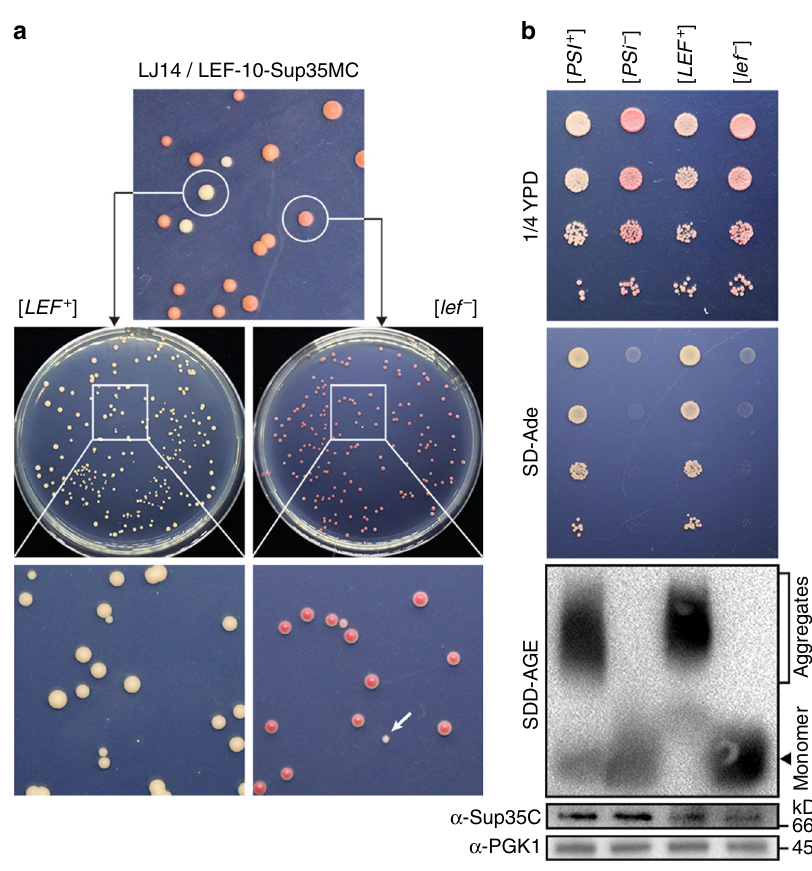
Fig. 2 LEF-10 functionally replaces the prion domain of the yeast Sup35 protein. a Yeast ade1-14 cells expressing LEF-10-Sup35MC were spread on complete (1/4 YPD) medium. [ LEF + ] strains formed white colonies which were distinguishable from [ lef − ] strains by the red pigment accumulated through the adenine biosynthetic pathway (top). Both phenotypes could be sustained during cell propagation (middle). [ lef − ] strains spontaneously generated [ LEF + ] colonies at a very low frequency (bottom, a colony with the [ LEF + ] phenotype is indicated by an arrow) and these [ LEF + ] colonies displayed Ade + (suppression of ade1-14 ) phenotype when tested directly on SD-Ade medium. b Comparable characteristics of LEF-10-Sup35MC and full-length Sup35 in yeast. Serial dilutions of [ LEF + ] and [ lef − ] strains were spotted on the 1/4 YPD plate (the top panel), or medium lacking adenine (SD-Ade) on which only prion-containing i.e., [ PRION + ] strains suppressing the stop codon in the yeast ade1-14 allele could grow (the second panel). SDS-resistant aggregates in cell lysates of yeast strains expressing LEF-10- Sup35MC were examined by SDD-AGE (the third panel). The expression levels of full-length Sup35 and LEF-10-Sup35MC were examined by Western blot, probing with a Sup35C-speci fi c antibody (the fourth panel). Endogenous phosphoglycerate kinase 1 (PGK1) was detected with a PGK1-speci fi c antibody and served as a loading control (the bottom panel). [ PSI + ] and [ psi - ] strains were used as positive and negative